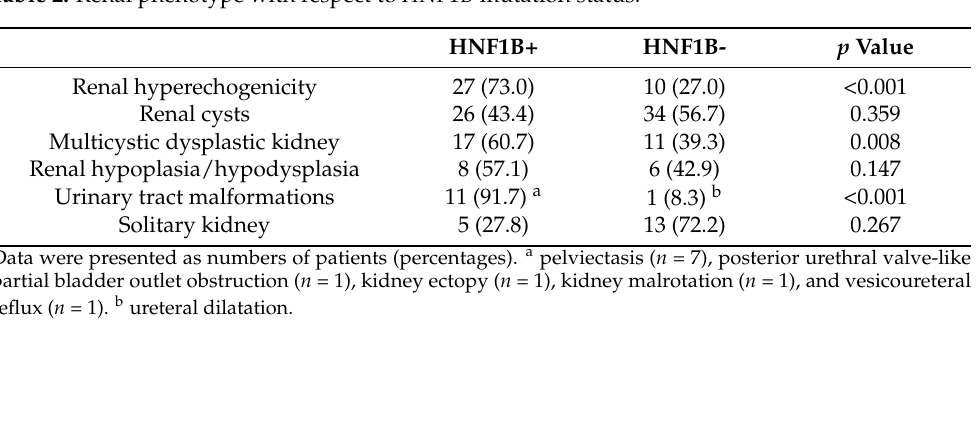
Table 2. Renal phenotype with respect to HNF1B mutation